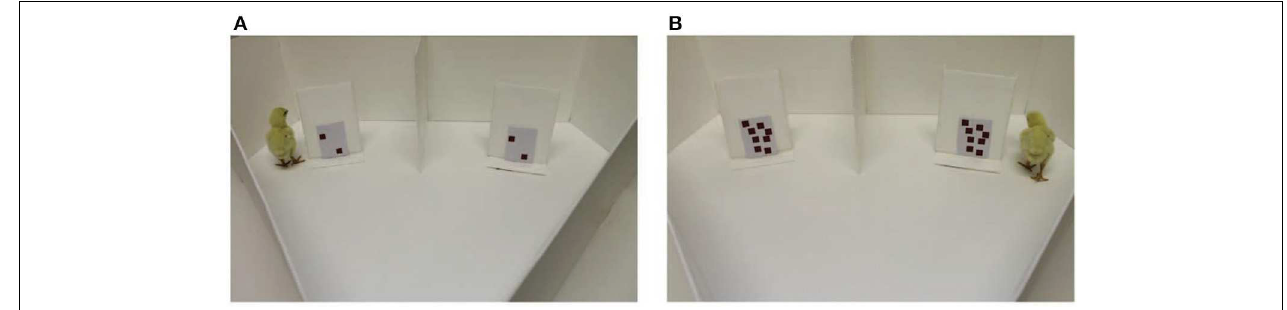
FIGURE 1 | (Figure re-used by permission from Rugani et al., 2015): The panels (A,B) differ in numerosity as well as lightness, density, perceptual mass, saliency, and visual complexity.